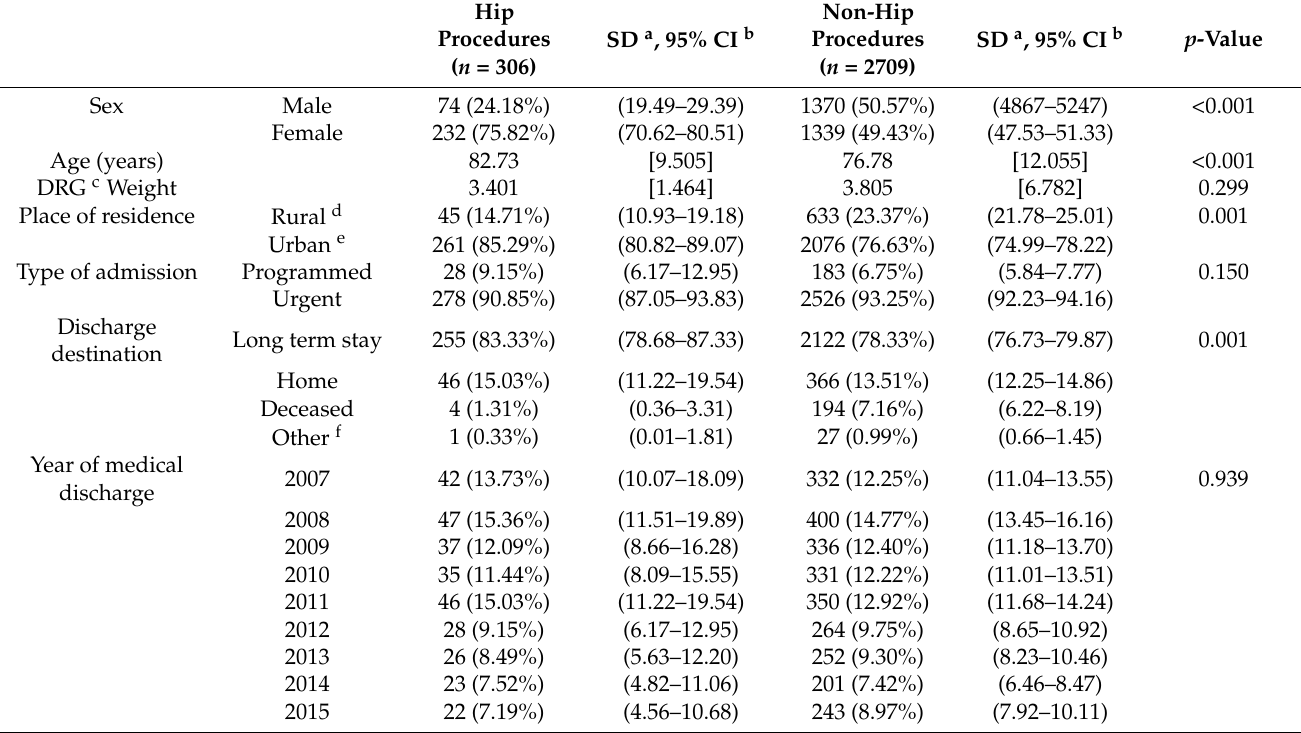
Table 3. Patients with hip procedures and compared with patients without hip procedures (patient characteristics and context of care). Cantabria (northern Spain),